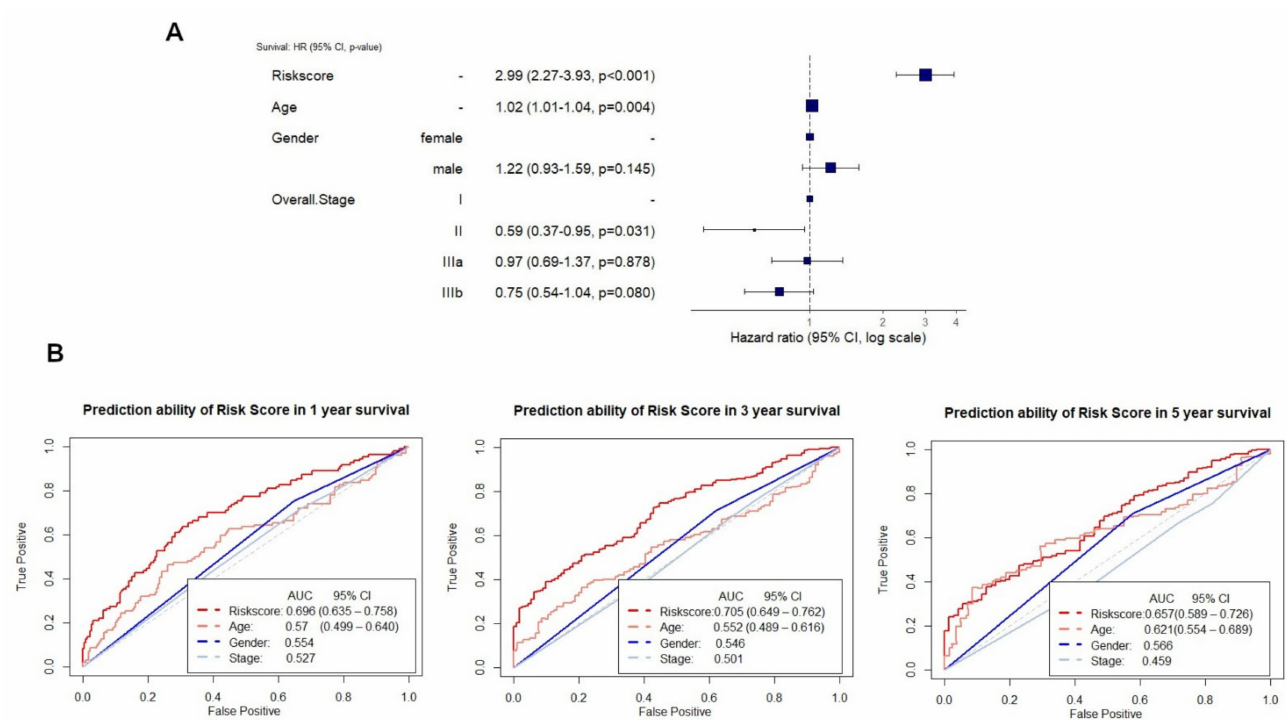
Figure 5. Risk score is an independent prognostic factor for survival prediction compared to clinical features in the training set. ( A ) Multivariate Cox regression showed that risk score was an independent prognostic factor for survival prediction compared to clinical features. ( B ) ROC curves compare risk score and clinical parameters (age, gender, stage) for survival prediction in 1 year, 3 years, and 5 years in the training